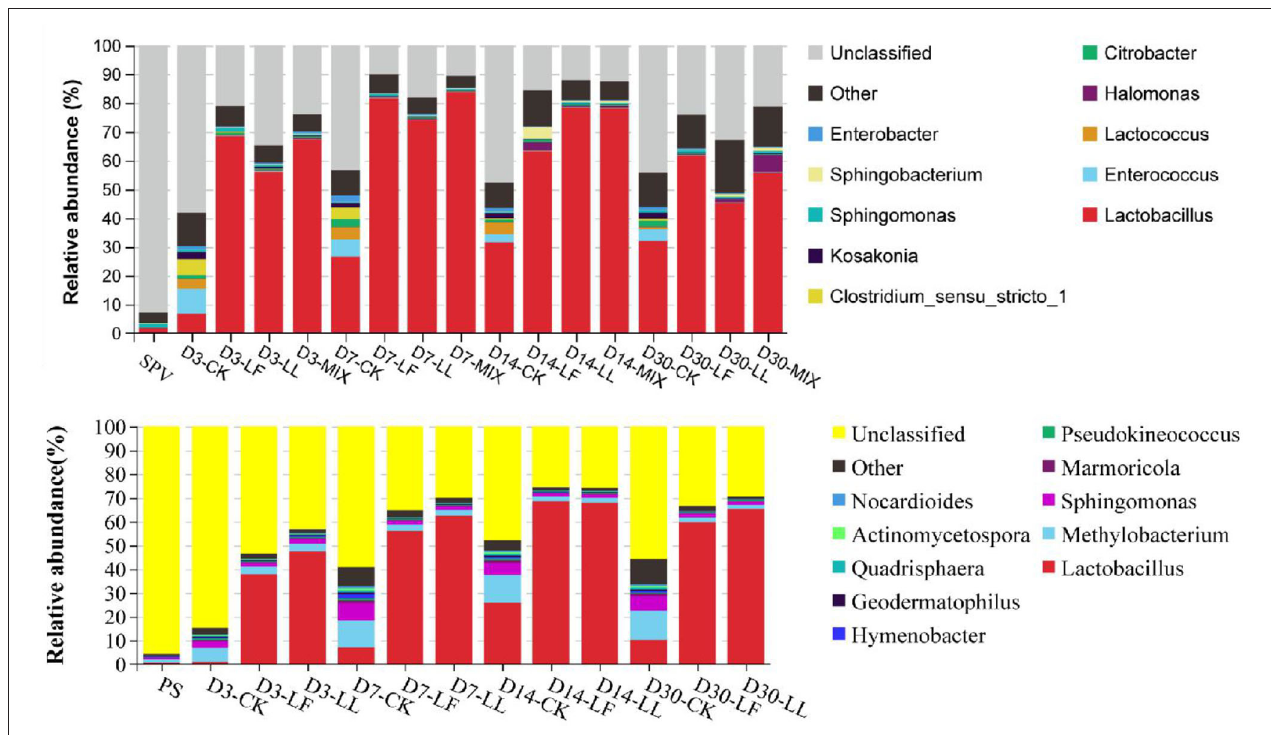
FIGURE 3 | Relative abundance of the bacterial community on genus level of inoculated or non-inoculated SPV and PS silage. SPV, sweet potato vine; PS, peanut straw; CK, non-inoculated silage (Control); LL, silage inoculated with Lactococcus lactis (LL); LF, silage inoculated with Lactobacillus farciminis (LF); MIX, silage inoculated with the mixture (1:1) of LL and